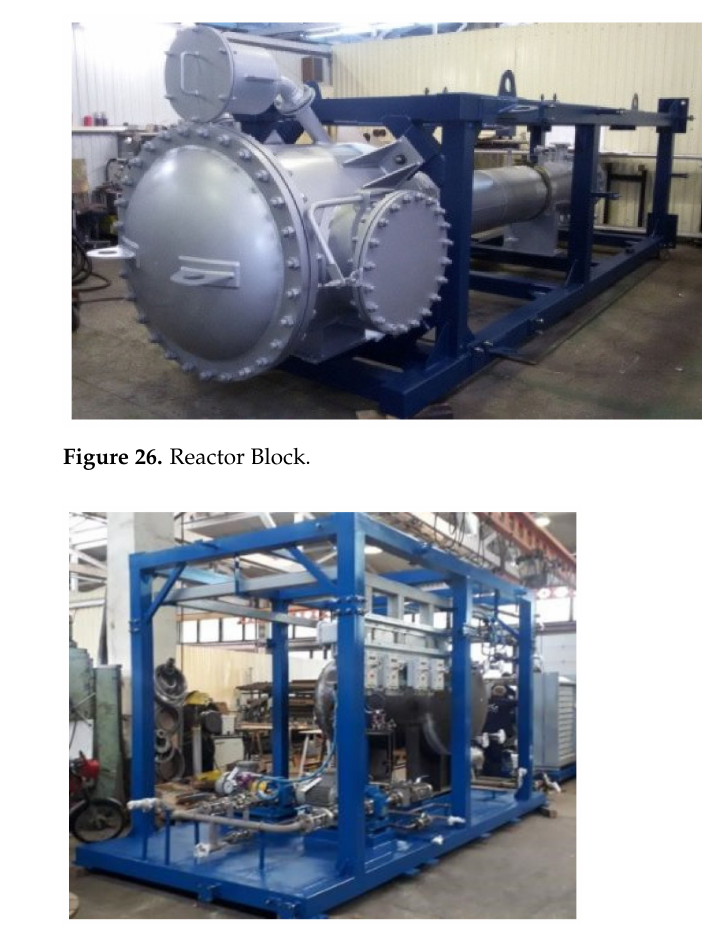
Figure 27. Cooling